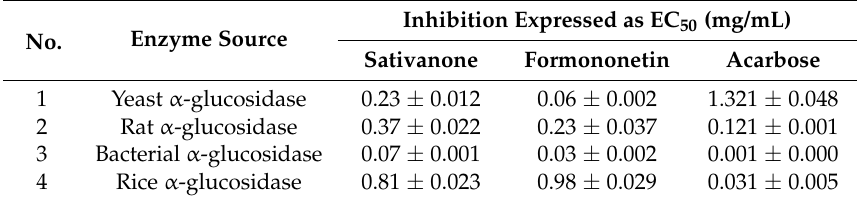
Table 3. Specific inhibitory activity of Sativanone, Formononetin, and Acarbose. Inhibition Expressed as EC 50 (mg/mL) No. Enzyme Source Sativanone Formononetin Acarbose 1 Yeast α -glucosidase 0.23 ± 0.012 Bacterial α